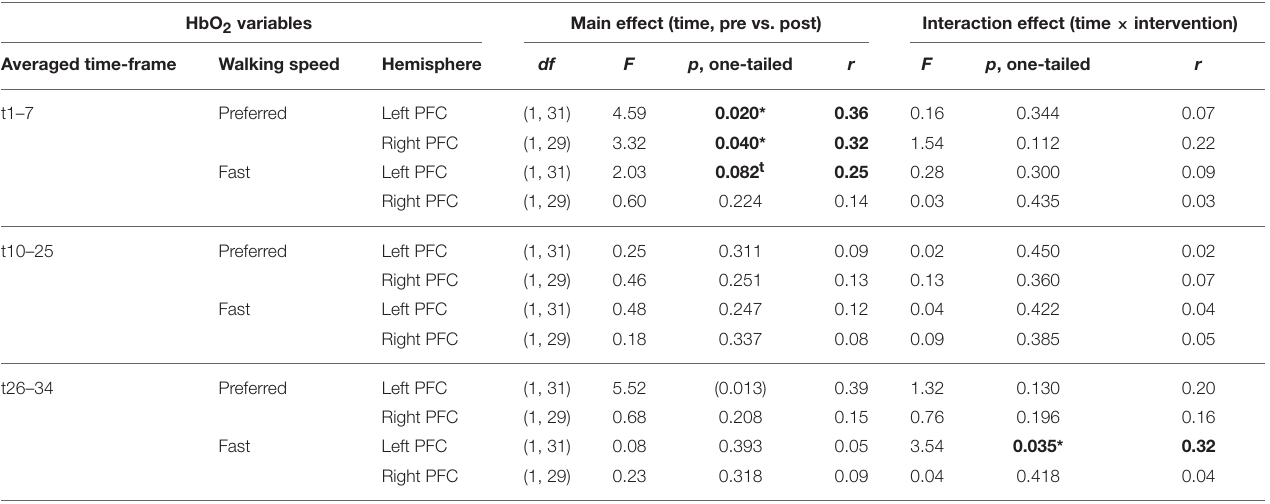
TABLE 2 | Results of repeated measures ANOVA for pre- vs. post-test PFC activity.